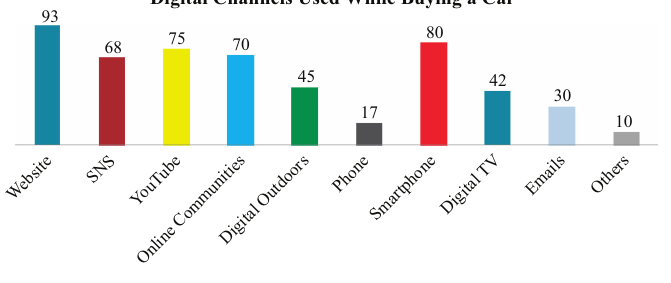
Figure 1. Most used